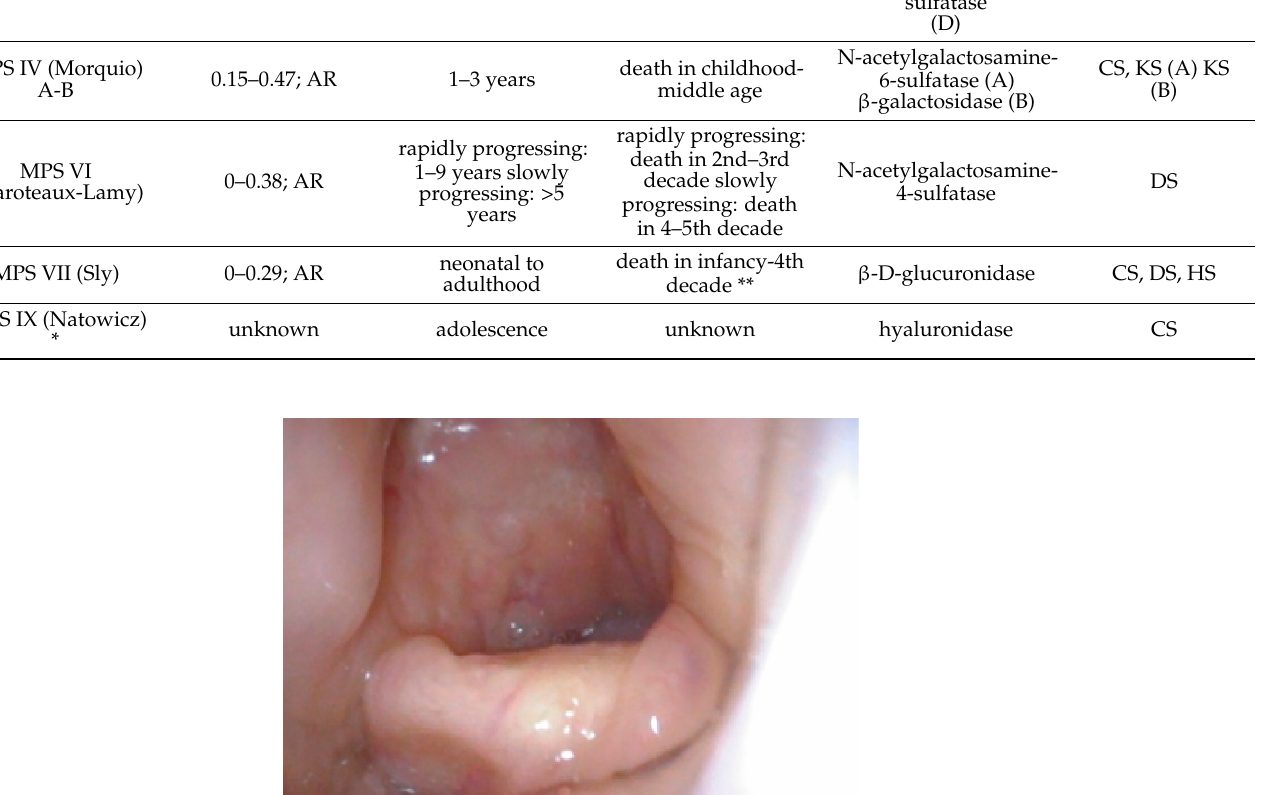
Figure 4. Line diagram sagittal section of the head and neck showing the upper airway and land- marks.